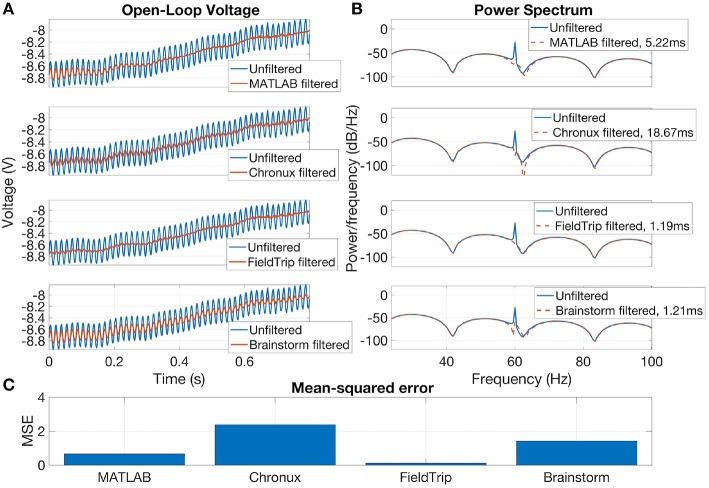
Open-loop voltage (A), Power spectrum (B), and Mean-squared error (C) for filtered with open-source toolboxes and unfiltered signal. FieldTrip (discrete Fourier transform filter, default parameters) provides the fastest and the most accurate line noise removal compared to MATLAB solution (Butterworth notch filter with 2 Hz width), Chronux (default 5 tapers, bandwidth 3) and Brainstorm (IIR notch filter with 1 Hz width). Filtering times are averaged over 1,000 runs, MATLAB 2016a.